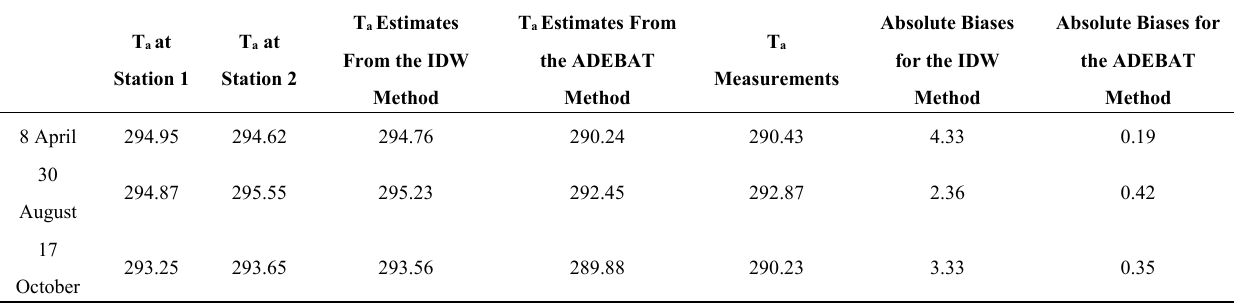
Table 2. Comparisons between the estimated air temperatures by the IDW method and the ADEBAT method and the T a measurements at Dongping Lake